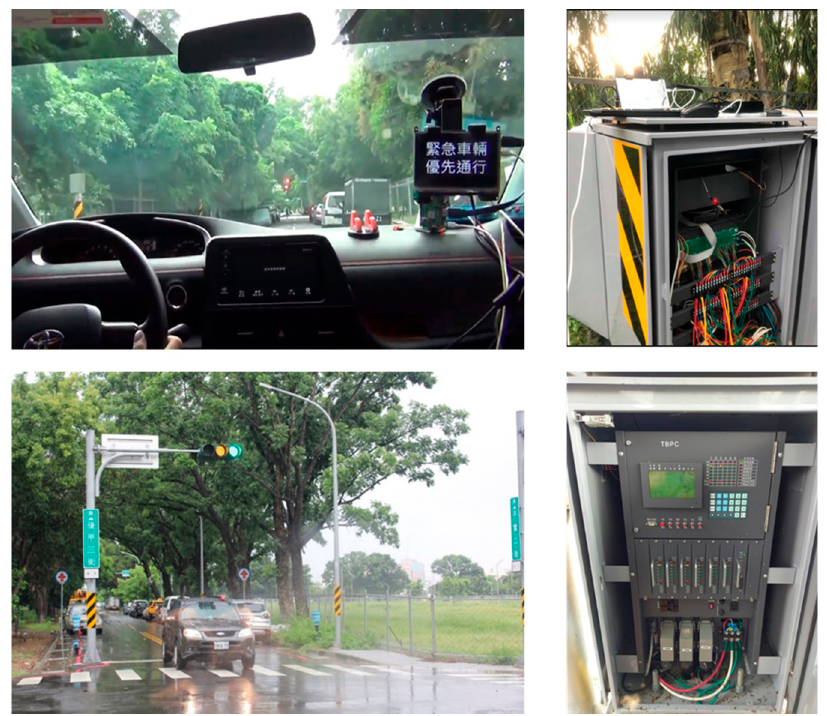
Figure 16. Pictures of Field test for the EVSP application (in Pingshi Park).